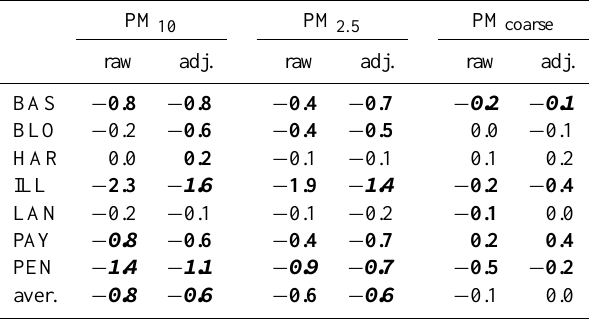
Table 6. Raw and meteorologically adjusted PM trends of the 90th quantile in µgm − 3 yr − 1 . Numbers in bold font indicate trends whose 95% confidence interval does not include zero. Numbers in italic font indicate trends that are significantly different than the cor- responding OLS trends in Table 5 at the 95% level of confidence. PM 2 .